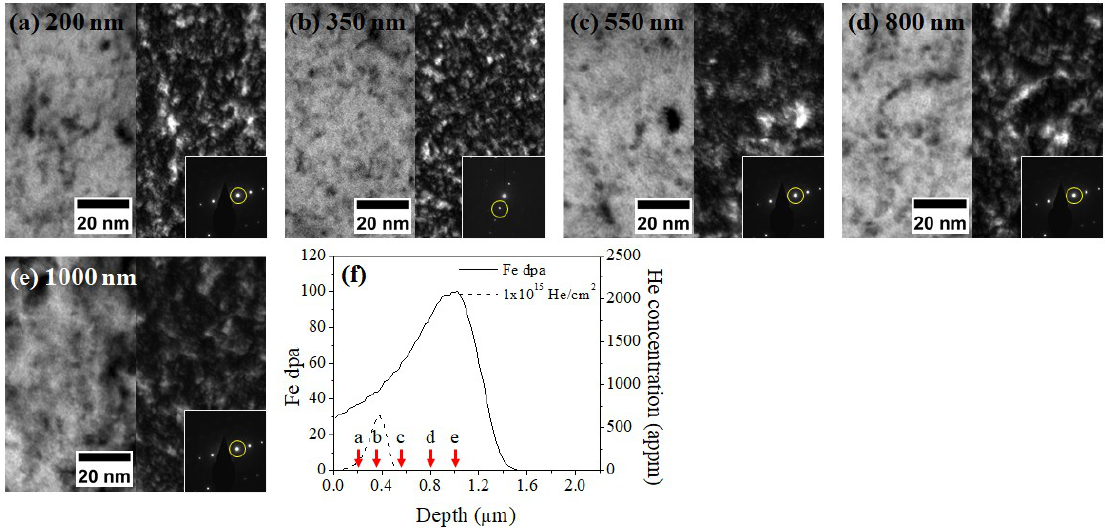
Figure 6. TEM bright-field and dark-field images of the 1 × 10 15 He preimplanted and Fe irradiated sample at depths of ( a ) 200, ( b ) 350, ( c ) 550, ( d ) 800, and ( e ) 1000 nm. Diffraction patterns obtained from the same grain are superimposed on each DF image with g110 marked by a yellow circle. ( f ) SRIM calculations of Fe, dpa, and He implant distributions are included, with red arrows indicating the depths of characterization. The dispersoid density was greatly increased in ( b ).